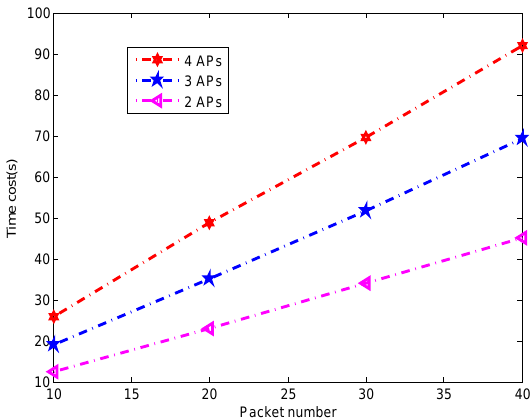
Figure 24. Time cost under different packet and AP